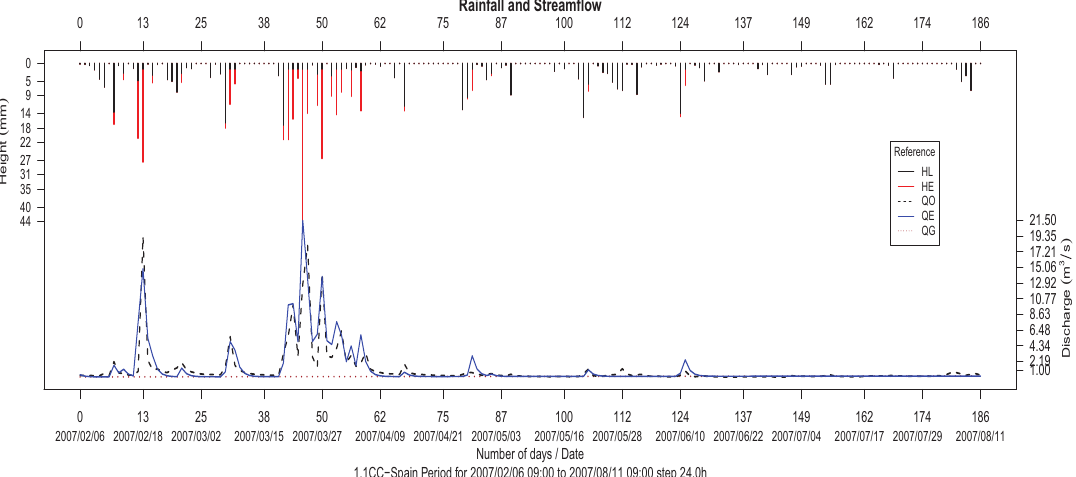
Figure 8. Hyetograph and Hydrograph from calibration data series 1.1CC of Asua basin, Bizkaia, Spain.